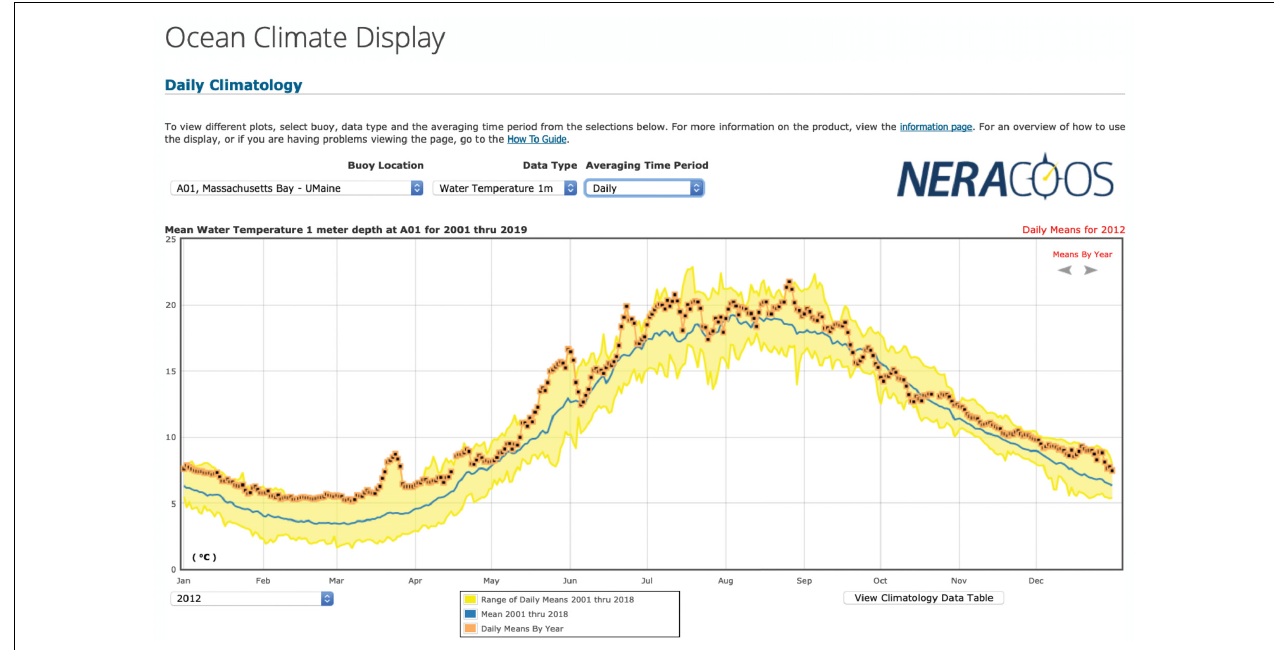
FIGURE 2 | The NERACOOS Ocean Climate Tool displays the daily average (blue line) and range (yellow area) of surface water temperatures at a buoy in the Gulf of Maine from 2001 to 2017. The 2012 daily mean water temperatures (black squares) demonstrate the “ocean heatwave” of 2012 when daily average surface water temperatures in the Gulf of Maine were consistently near or above the maximums measured in the previous decade. Image courtesy of